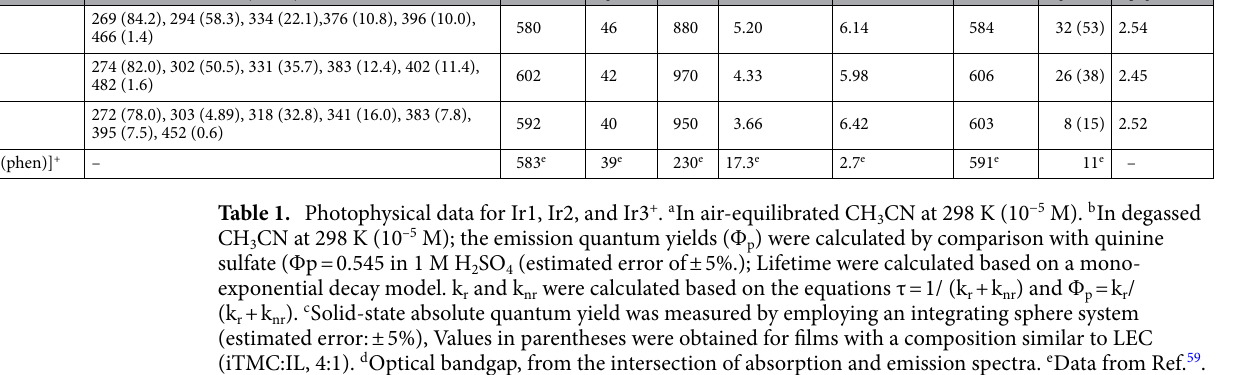
Absorption (cid:31) abs [ nm ] (cid:31) ε/ 10 3 (cid:30)